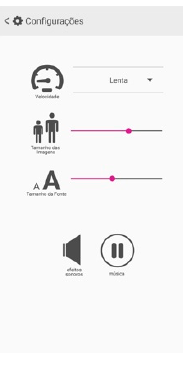
( b ) Figure 1. Game screens from the paper prototype: ( a ) launch screen; ( b ) home screen. The game narrative focused on an action game, based on Prena’s [21] advice, and it starts with a big park opening, when its owner decides to raffle one ticket for early entry. Hence, the player is the lucky person that can arrive at in the park and early tries to make the most of it, collecting prizes for him and for his friends that could not enjoy it with him. The game is divided into five levels: each one works with a singular touchscreen gesture and they all look like real park games, but with some little differences which will be described below. Another aspect of great importance is that the player cannot lose in Parque das Galáxias; he has as many chances as he likes, as recommended by the manual from AbleGamers Foundation [9], but, as a motivational incentive, if the player completes the level goal with fewer errors, his score becomes higher and it gives him the opportunity of better prizes each time. The rewards are accessories and toys for the main character, which the player can send to his real friends or take a picture of them. In this way, the first level is a basketball game, where the basket goes from side to side of the screen; the ball is centered at the bottom and the player should touch the screen to throw it straight (Figure 2a). The second level requires the player to get the spaceship to the planet. To do this, he should use the double-tap gesture to trigger the sledgehammer; after the first tap, a strength bar